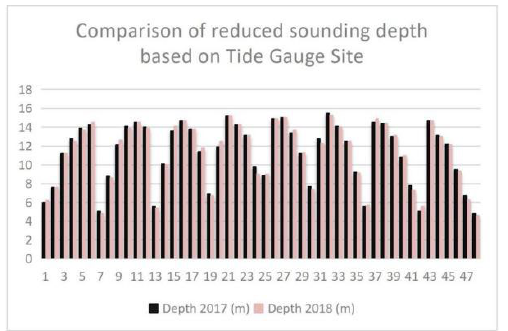
Figure 22. The depth comparison between 2017 and 2018 relative to the on-site tide gauge